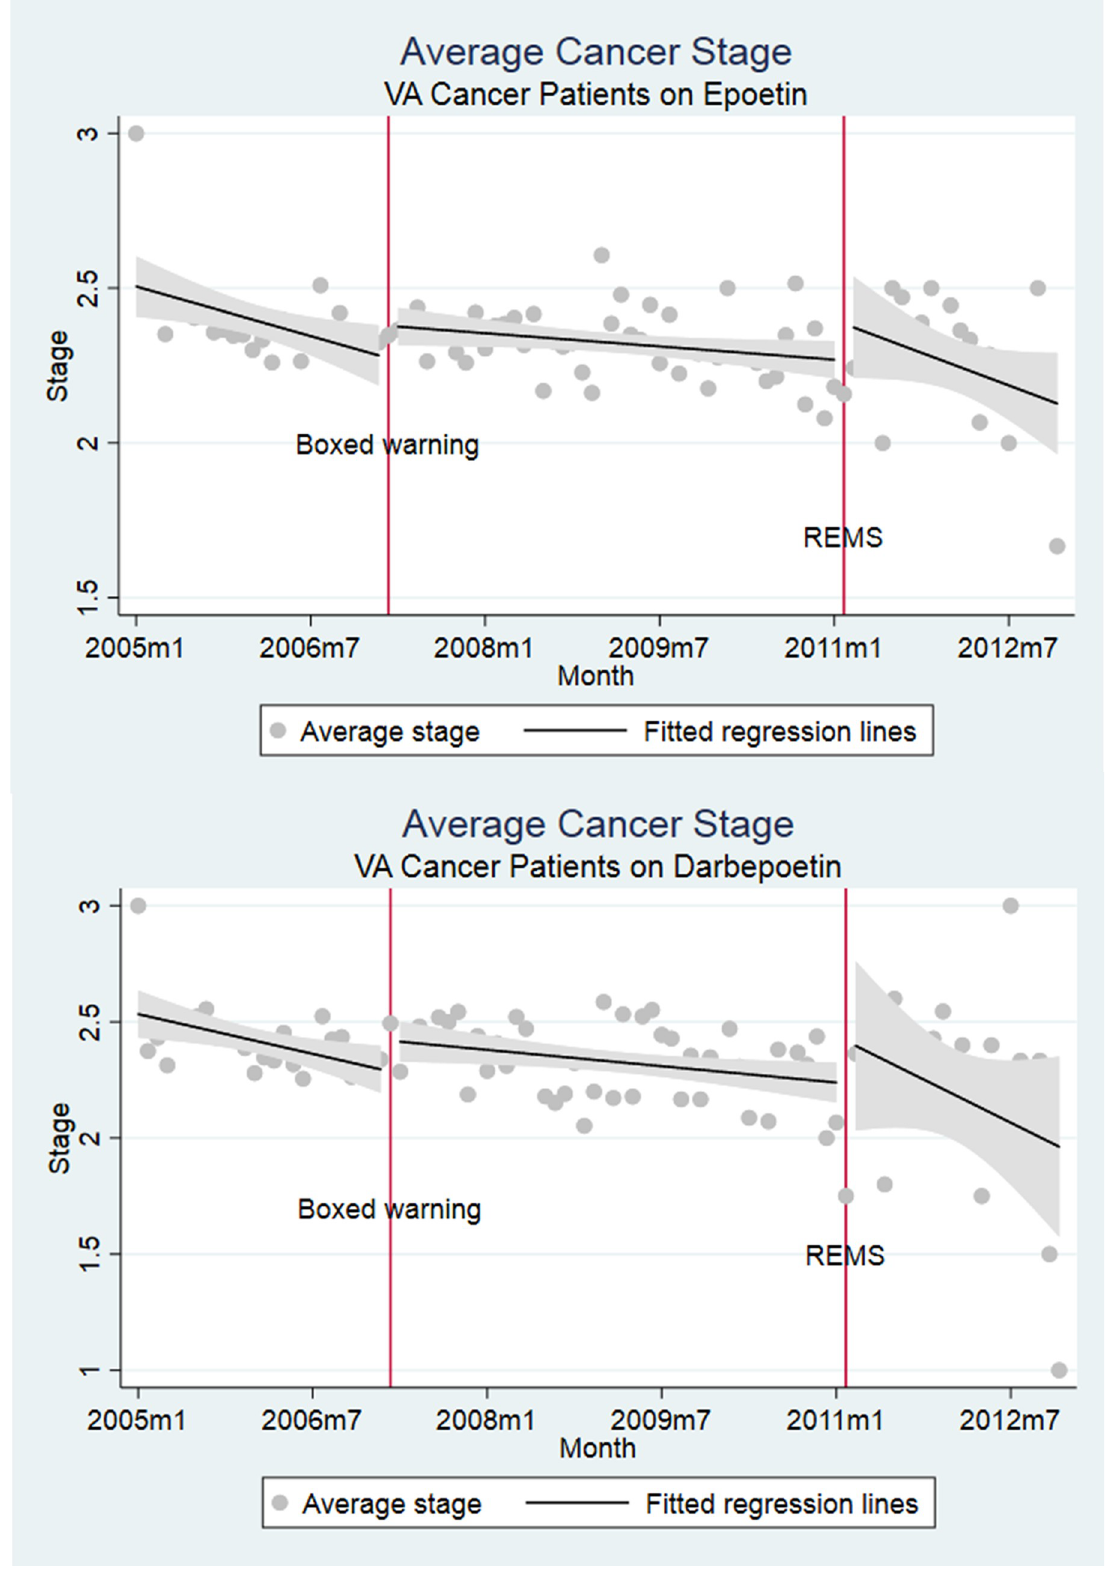
Fig 4. Average cancer state of VA cancer patients for (a) epoetin and (b) darbepoetin. https://doi.org/10.1371/journal.pone.0234541.g004 PLOS ONE | https://doi.org/10.1371/journal.pone.0234541 June 25,